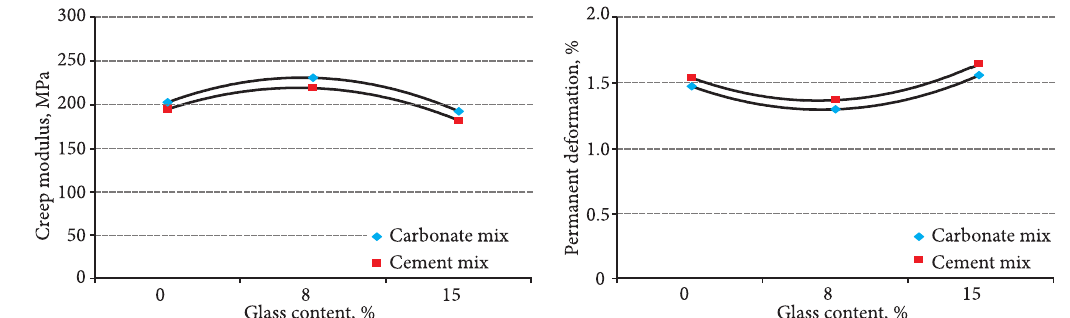
Fig. 3. Results of the cyclic triaxial compression